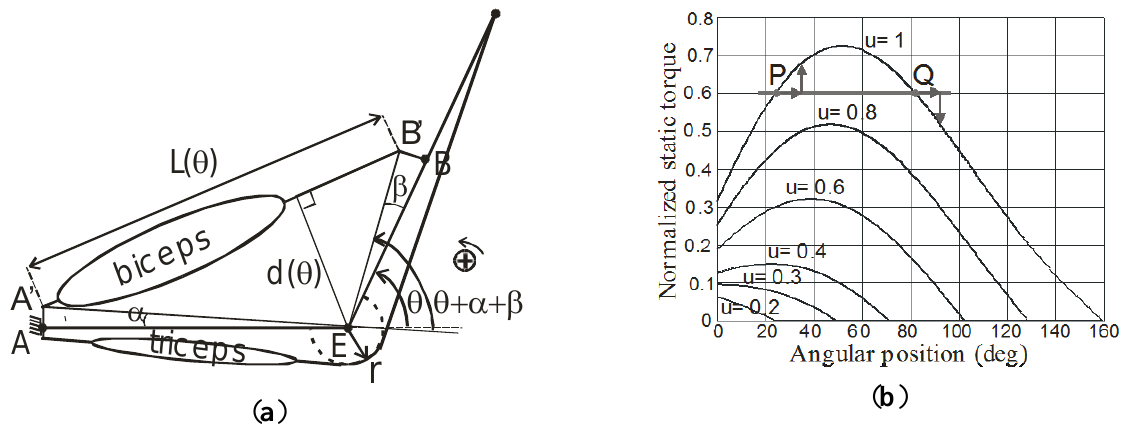
Figure 8. Elbow-type artificial muscle actuator, ( a ) actuator scheme, and ( b ) corresponding torque-angle characteristic (see